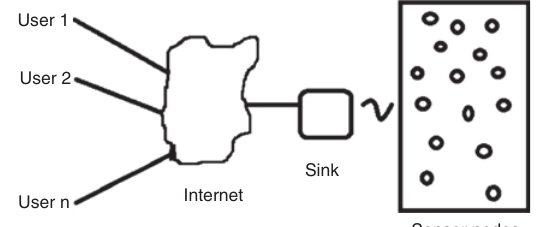
Figure 1: Network Environment.